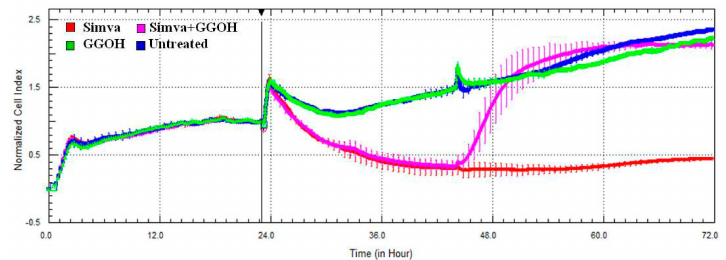
Figure 4. Impedance profiles after Simvastatin treatment. Daoy were seeded (5 ˆ 10 5 /well) in E-plate and treated (at Time 0, after about 24 h seeding) with Simvastatin 10 µ M and with GGOH 50 µ M (after about 48 h seeding). The graph shows the Normalized Cell Index, at the time of the first stimulation (Time 0), indicated by the vertical black line. The experiment was performed in triplicate. Simva (red), GGOH (green), Simva + GGOH (pink), Untreated